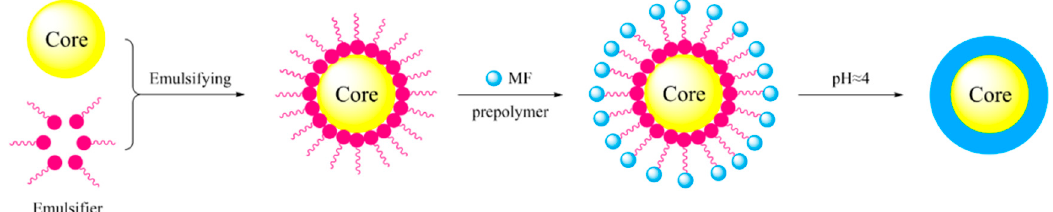
Figure 1. Basic process of in situ polymerization.